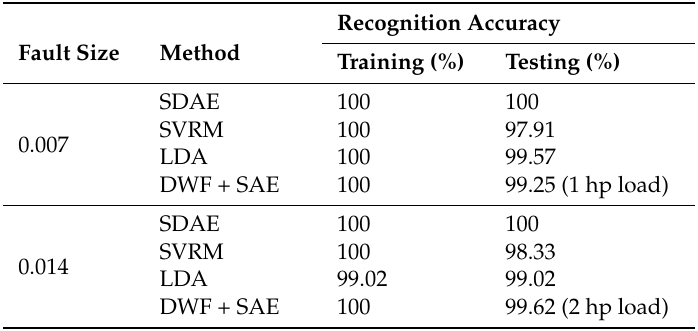
Table 3. Comparison of different Methods in CWRU data